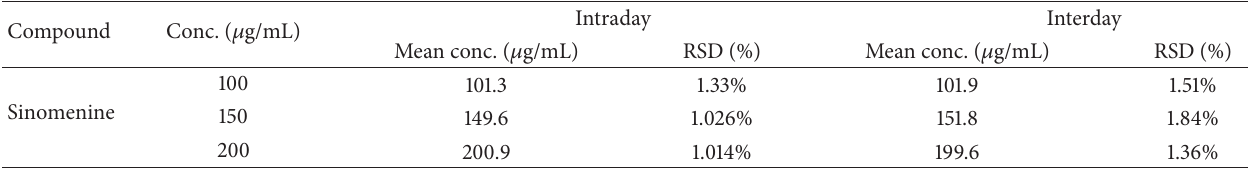
Table 1: The intraday and the interday precision ( 𝑛 = 3